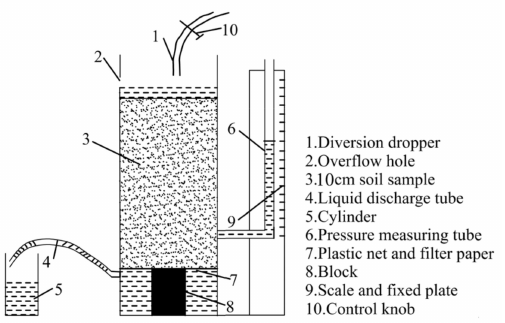
Figure 1. A self-made column leaching device for the permeability test of the ore